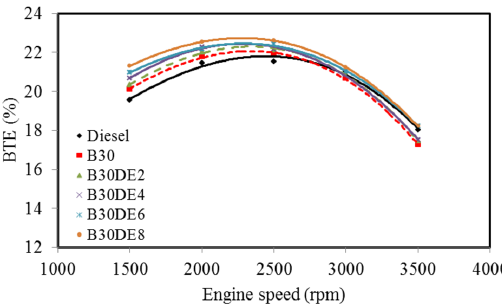
Figure 10. Variation of engine brake thermal efficiency (BTE) for different diethyl ether additive ratios.